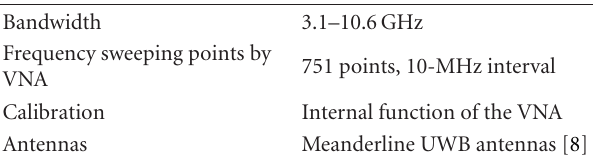
Table 1: Specifications of the propagation measurements